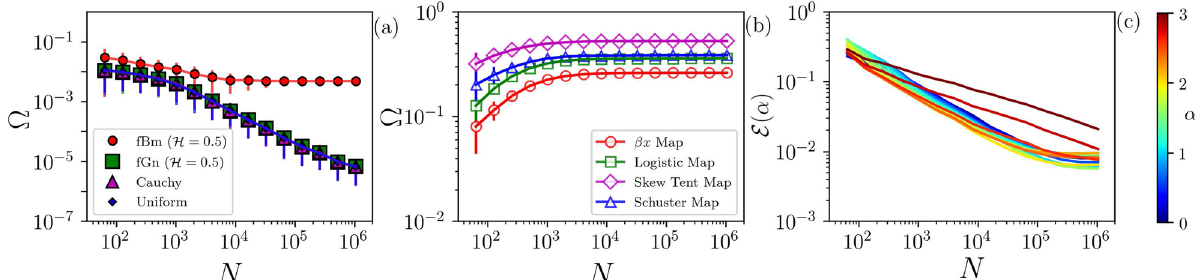
Figure 5. Robustness with respect to the time series length. We evaluate (cid:31) as a function of the time series length N for stochastic signals ( a ) and chaotic ones ( b ). In ( a ), we observe that even for N < 100 , � < 0.1 , which confirms the stochastic nature of the signal. In ( b ), even for N < 100 , � > 0.1 (except for β x map). Also, � > 0.2 for all cases for N ≥ 1000 , which classifies the signals as chaotic even with only 1000 datapoints. The error bars are the standard deviation over 1000 of samples. ( c ) Mean absolute error, E , between the output of the ANN ( α e ), and the parameter α used to generate the time series of flicker noise (depicted in color-code) as a function of the length of the time series, N .